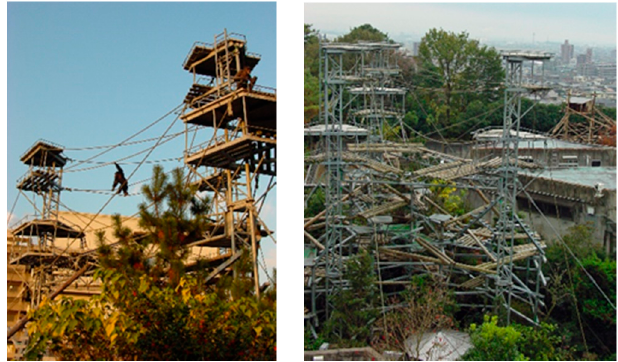
Figure 5. Two of the three functionally naturalistic chimpanzee towers developed by Tetsuro Matsuzawa (Photos: J. Coe).